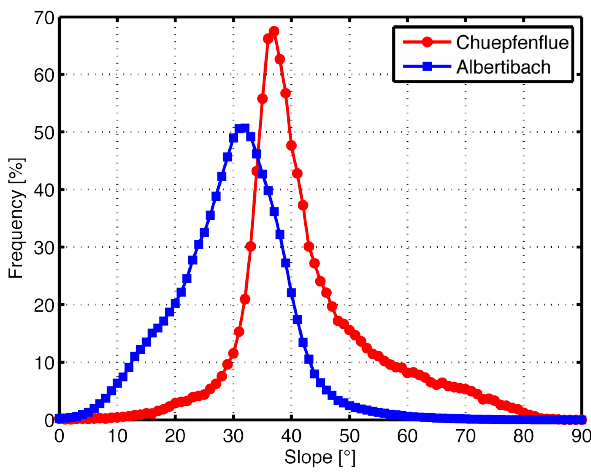
Fig. 2. Histogram with the relative frequency (calculated for classes with a step width of 1 ◦ slope) of the slope.